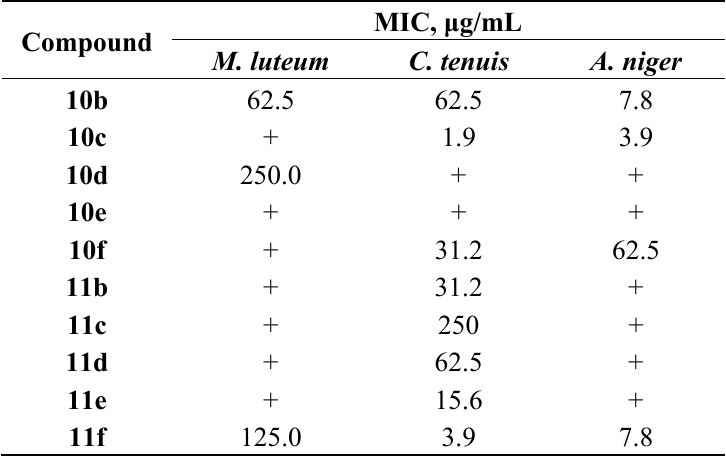
Table 2. Bactericidal and fungicidal activity of 10b – f and 11b – f determined by the serial dilution